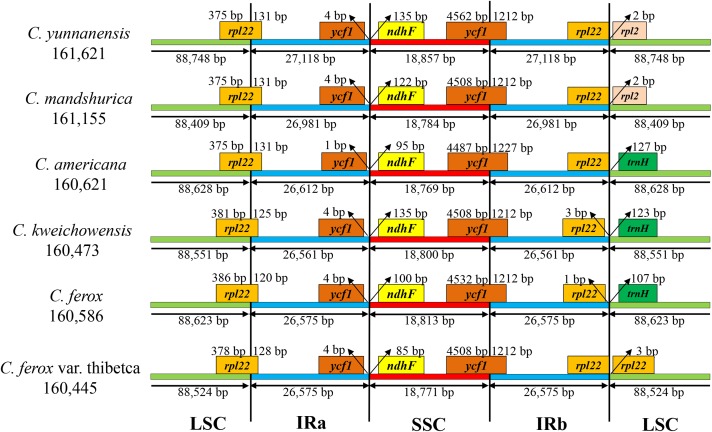
The comparison of the LSC, IR, and SSC border regions among the six Corylus chloroplast genomes.